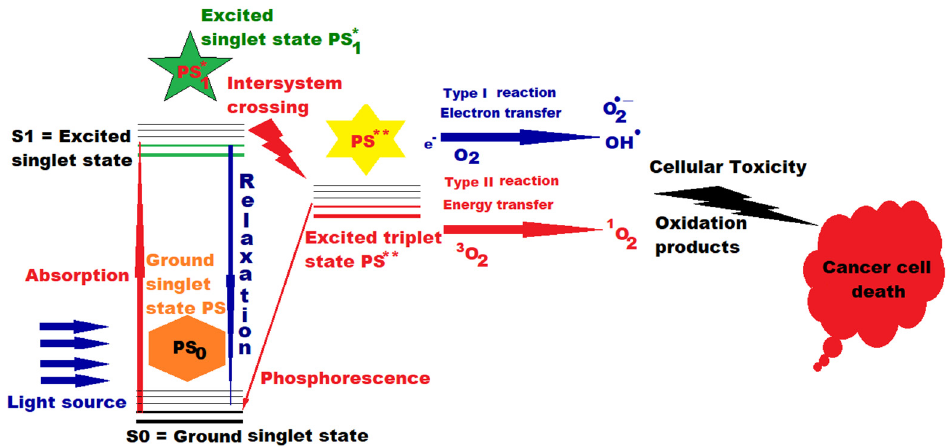
Figure 1. Action of PDT and photosensitizer (PS) in cancer therapy. A single asterisk “*” means “excited singlet state”, and two asterisks “**” mean “excited triplet state”. PS had an inherent basis in nature through the green pigment chlorophyll, existing in all green plants and in cyanobacteria, absorbing light to deliver the photosynthesis’ energy, as well as other light-sensitive molecules in the plant